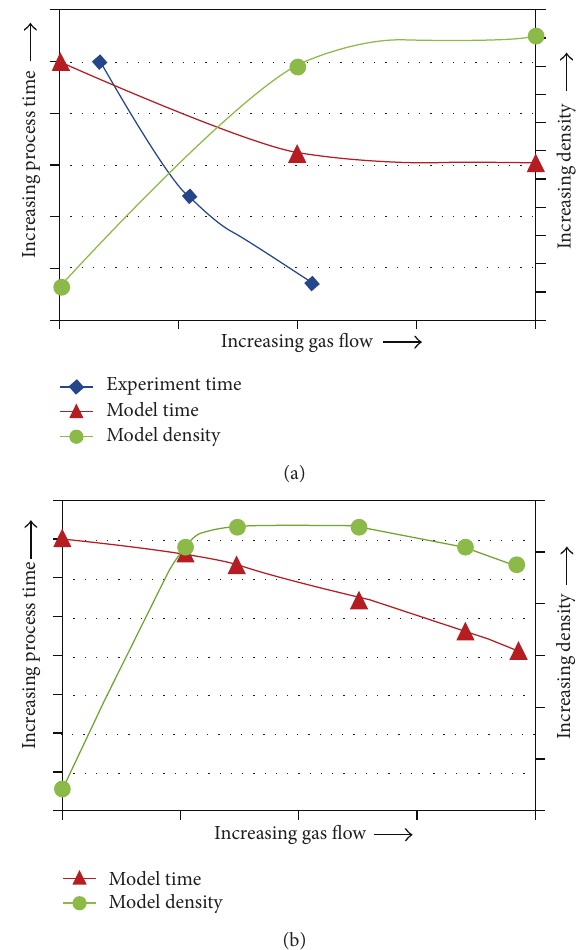
work, showing effects of reactant velocity and (b) simulation results from Roman et al., [15] showing similar trends with increasing gas